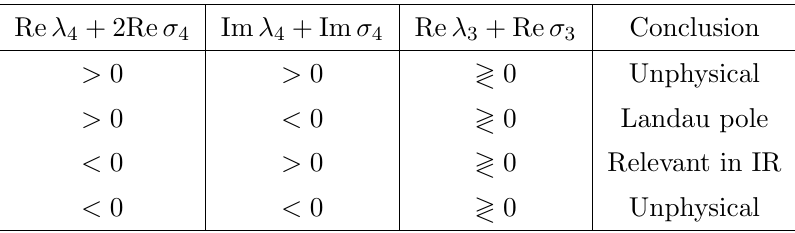
Table 3. Running of coupling